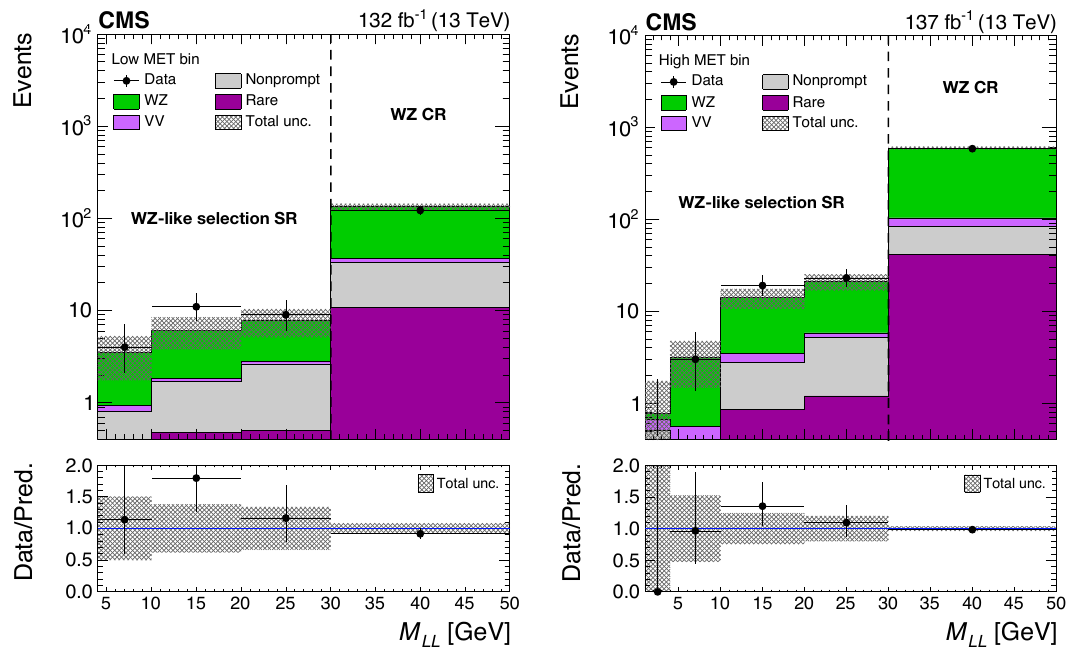
Figure 3 . The post-fit distribution of the M ( ‘‘ ) variable is shown for the low- (left) and high- (right) MET bins for the WZ -enriched region. Uncertainties include both the statistical and sys- tematic